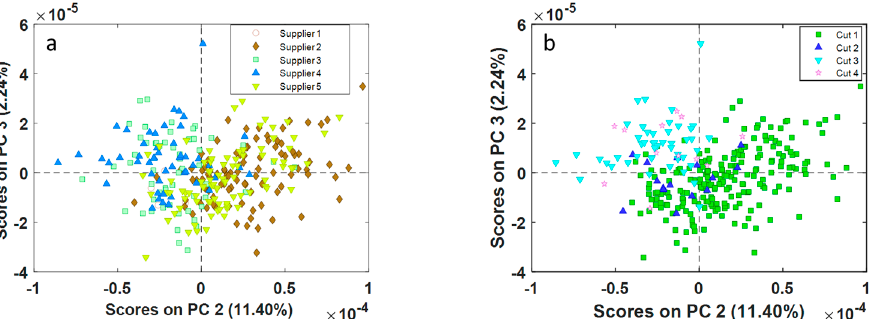
Figure 3. Results of the Exploratory Data Analysis performed on NIR data. PC2 vs. PC3 scores plots colored by different suppliers ( a ) and cuts ( b ).